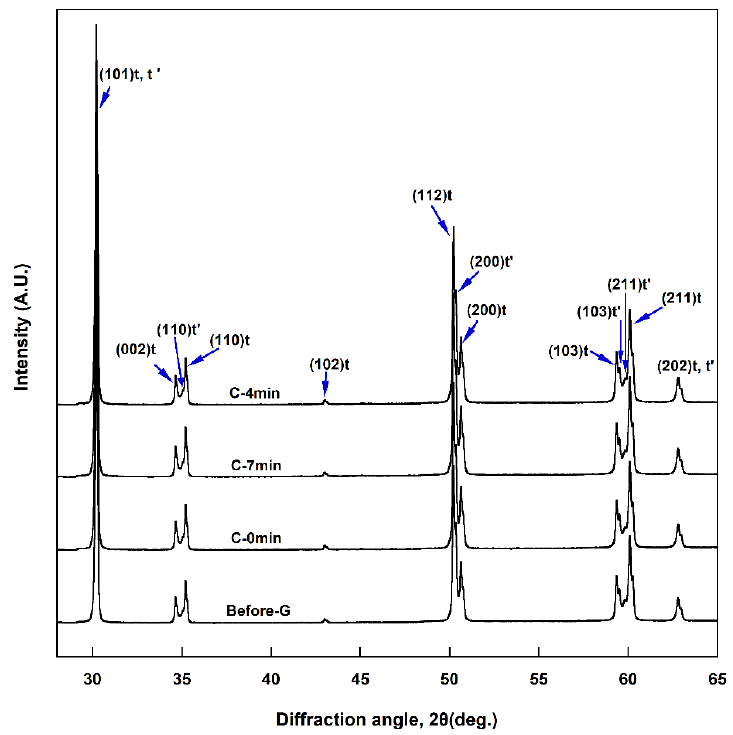
Figure 6. XRD patterns of specimens before and after glazing at various cooling rates.